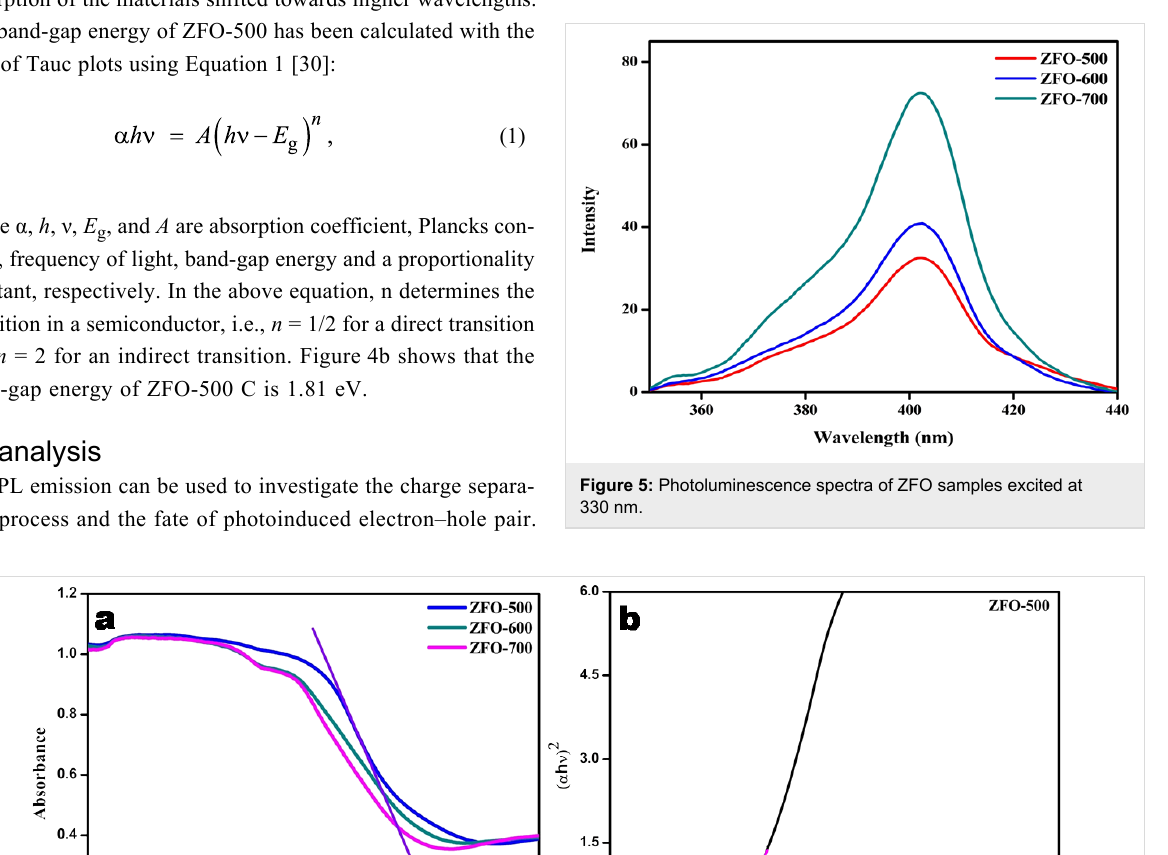
The samples show a wide absorption range from 200 to 700 nm highest absorption. With increasing calcination temperature the absorption of the materials shifted towards higher wavelengths.